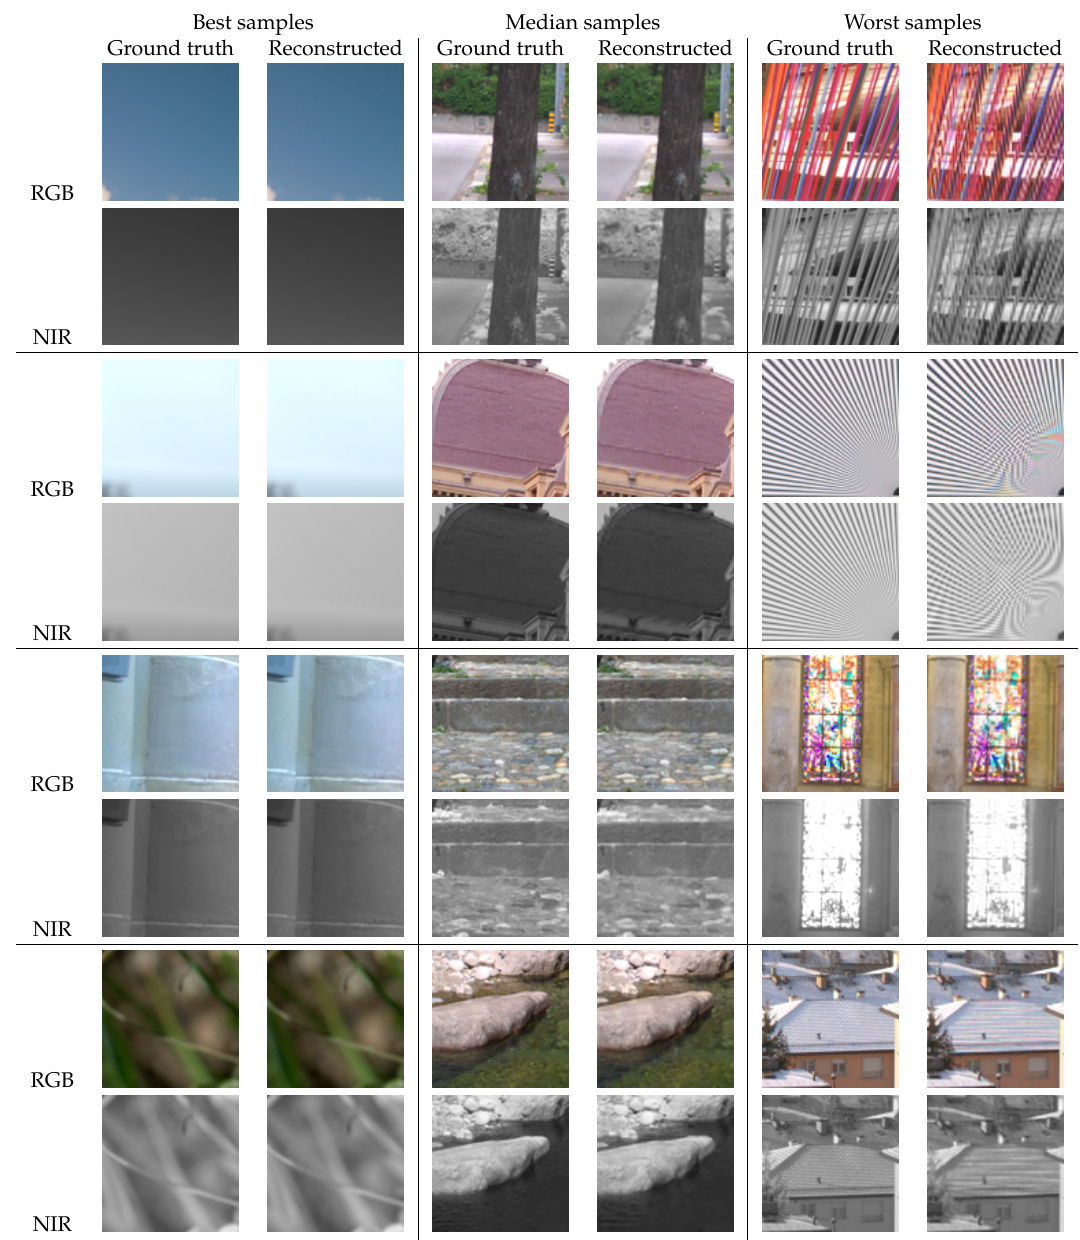
Figure 13. Selected crops from test images with the best, median, and worst